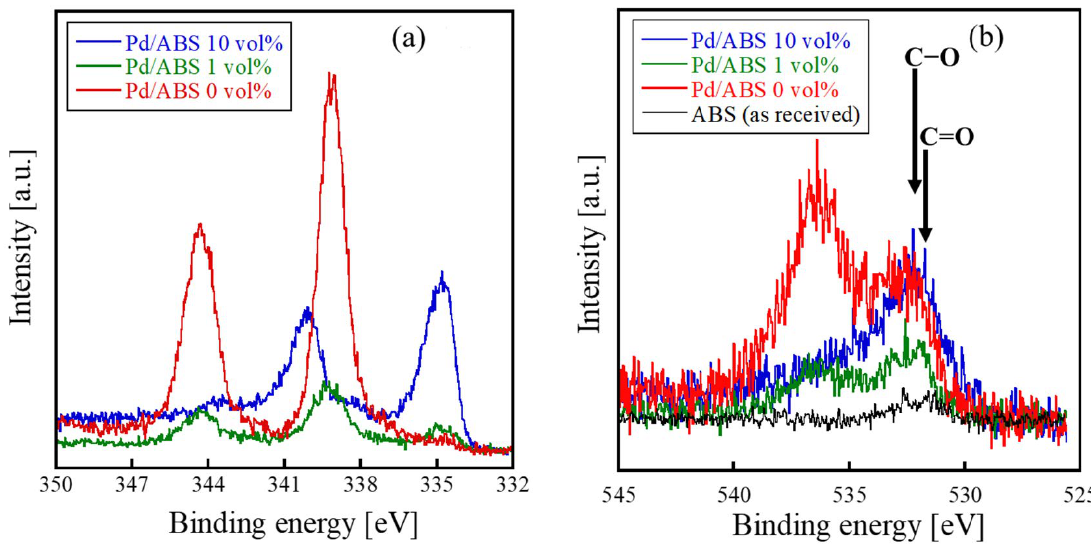
Figure 2. XPS spectra of Pd/ABS: ( a ) Pd3 d , ( b ) O1 s .